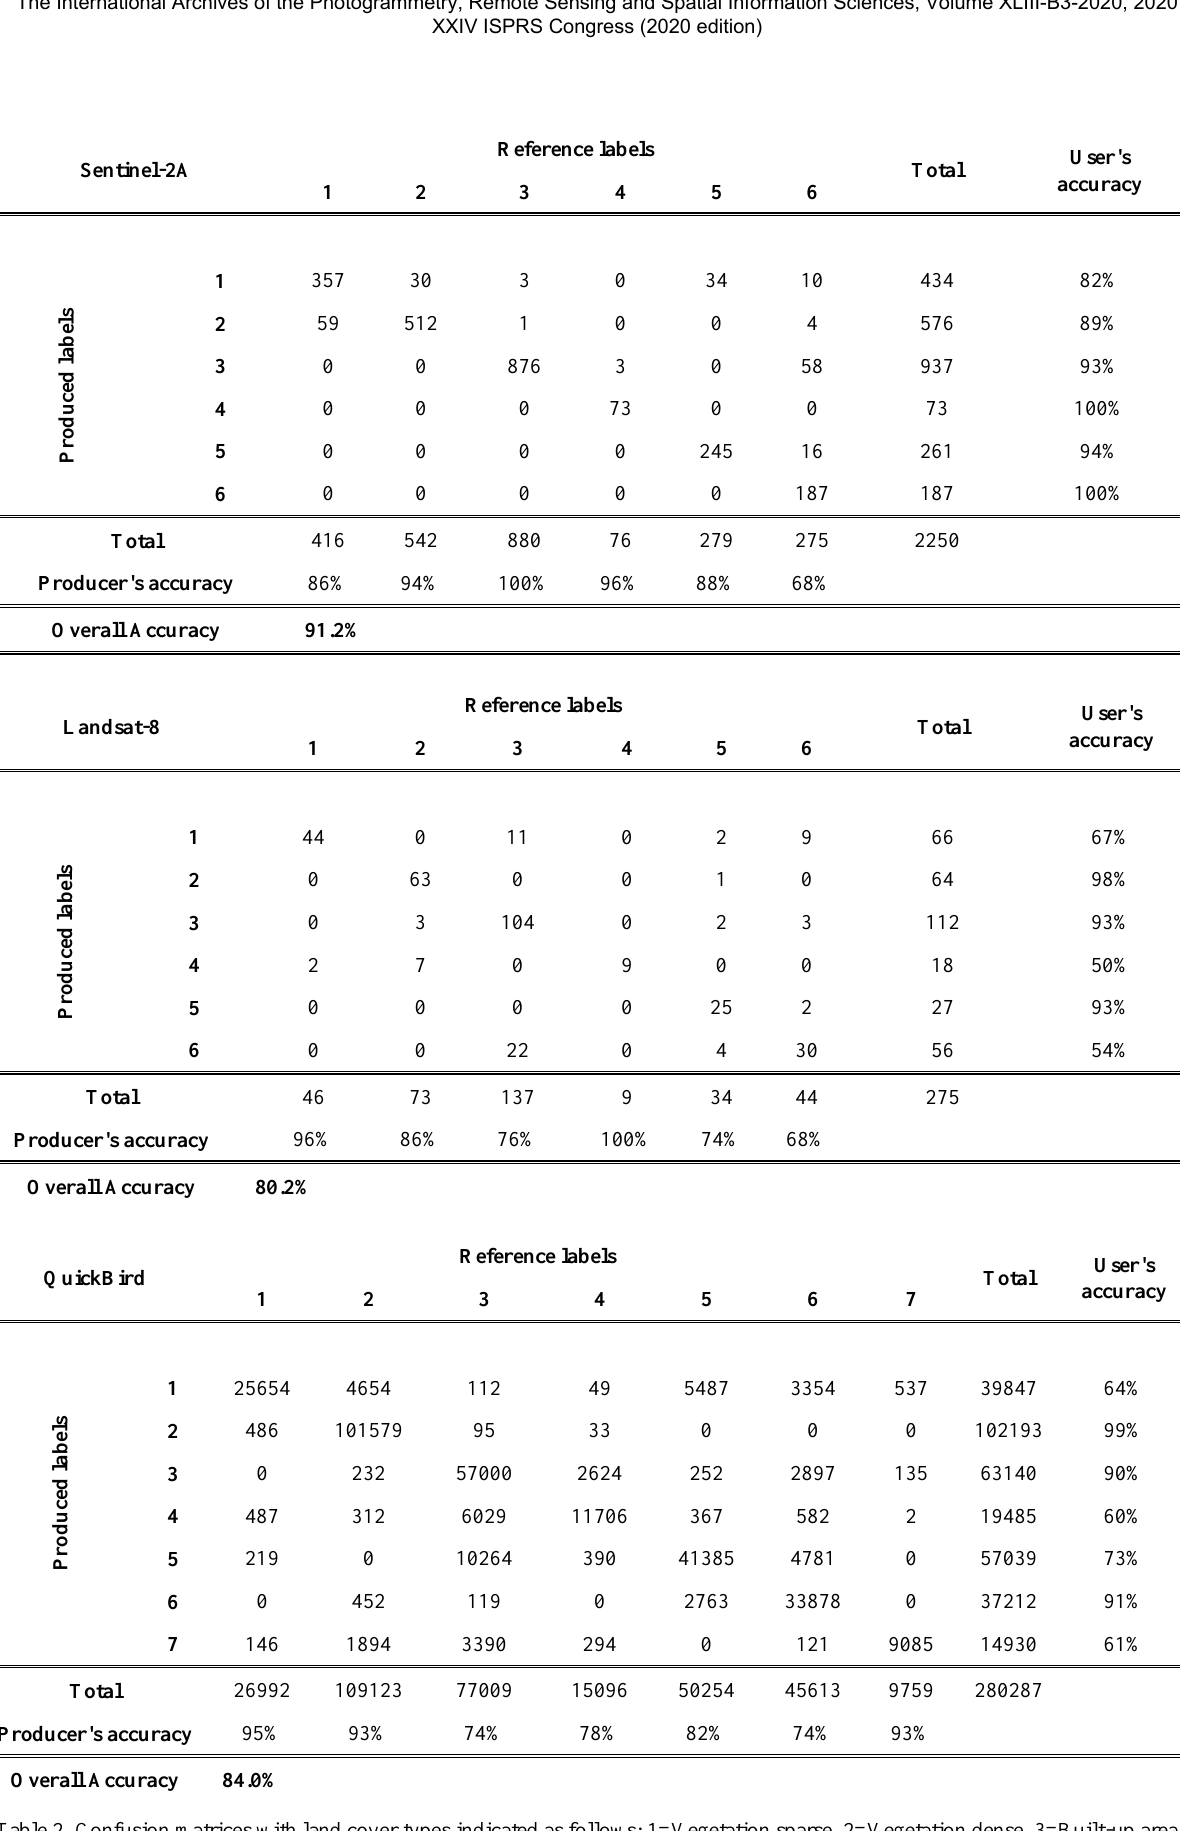
Table 2. Confusion matrices with land cover types indicated as follows: 1=Vegetation sparse, 2=Vegetation dense, 3=Built-up area, 4=Roads, 5=Cultivated land, 6= Barren land,